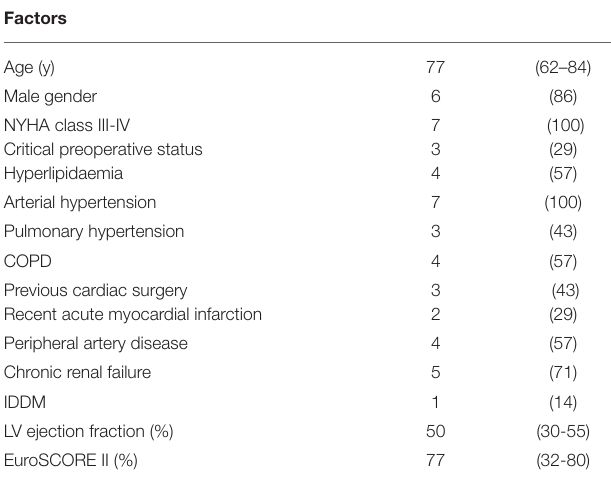
TABLE 1 | Pre-operative clinical